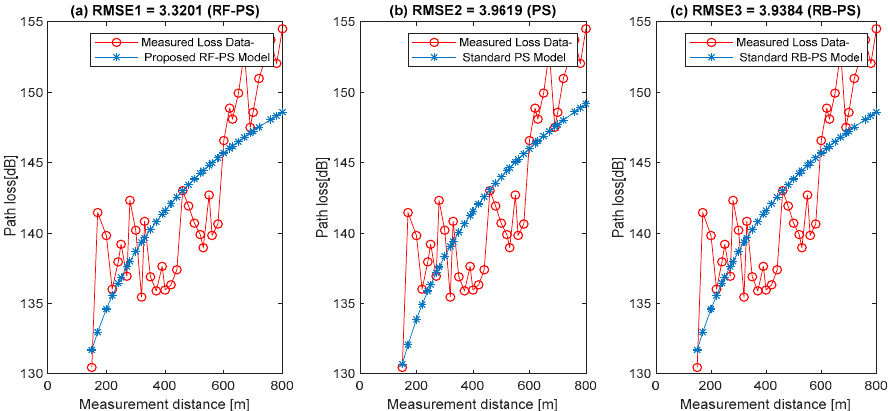
Figure 10. Results showing the measured path loss versus distance using the hybrid RF-PS method and two existing standard path loss prediction methods in site 3 of location 1.